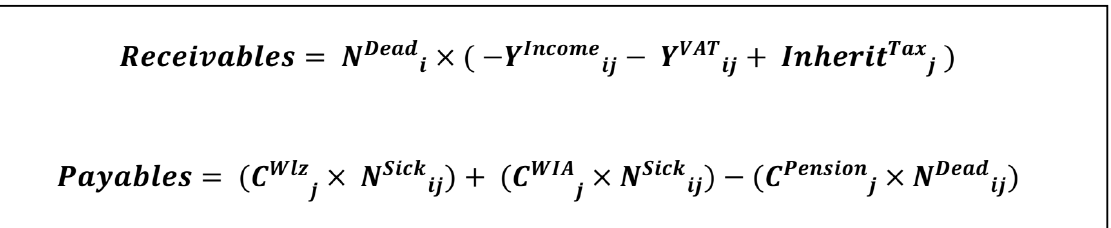
Figure 2. Abbreviations: N: number of subjects, Y: Tax revenue, Inherit: Inheritance, i: per age cohort, j: per capita, C: pay-out category (costs), Wlz: Long-term care, WIA: Work disability.